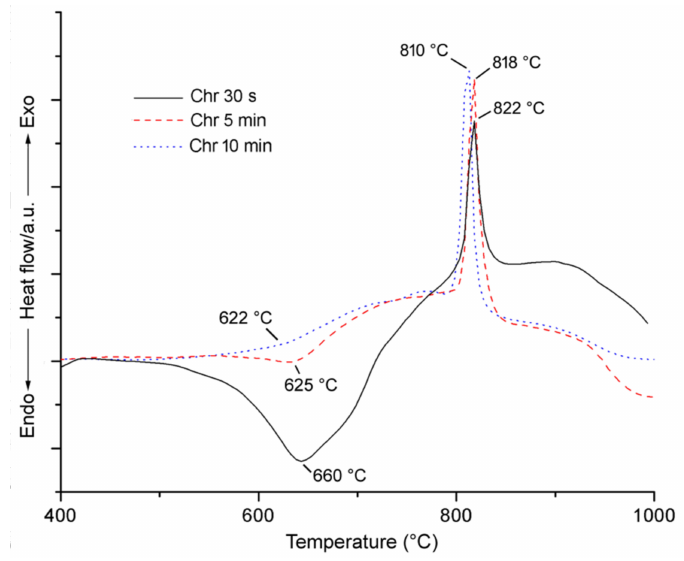
Figure 4. Differential scanning calorimetry of chrysotile after 30 s, 5 min and 10 min of grinding time. The exothermic peaks on the DSC curves (822, 818 and 810 ◦ C) indicate forsterite (Mg 2 SiO 4 ) and enstatite (MgSiO 3 ) crystallization (e.g., [46,52]). Forsterite (JCPDS card 34-0189) and enstatite (JCPDS card 22-0714) were identified by XRPD as the main crystalline phases formed after combined grinding for 30 s, 5 and 10 min and thermal treatments at 1000 ◦ C (Supplementary Figure